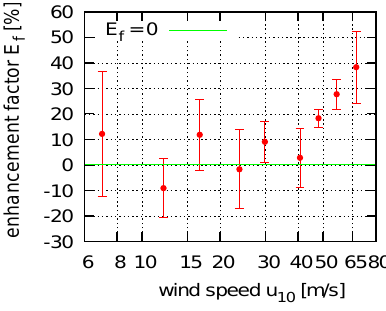
Fig. 7. Mean enhancement of the transfer velocity of HFB over that of DFB, both scaled to a Schmidt number of 600. An E f of 0 means no enhancement.